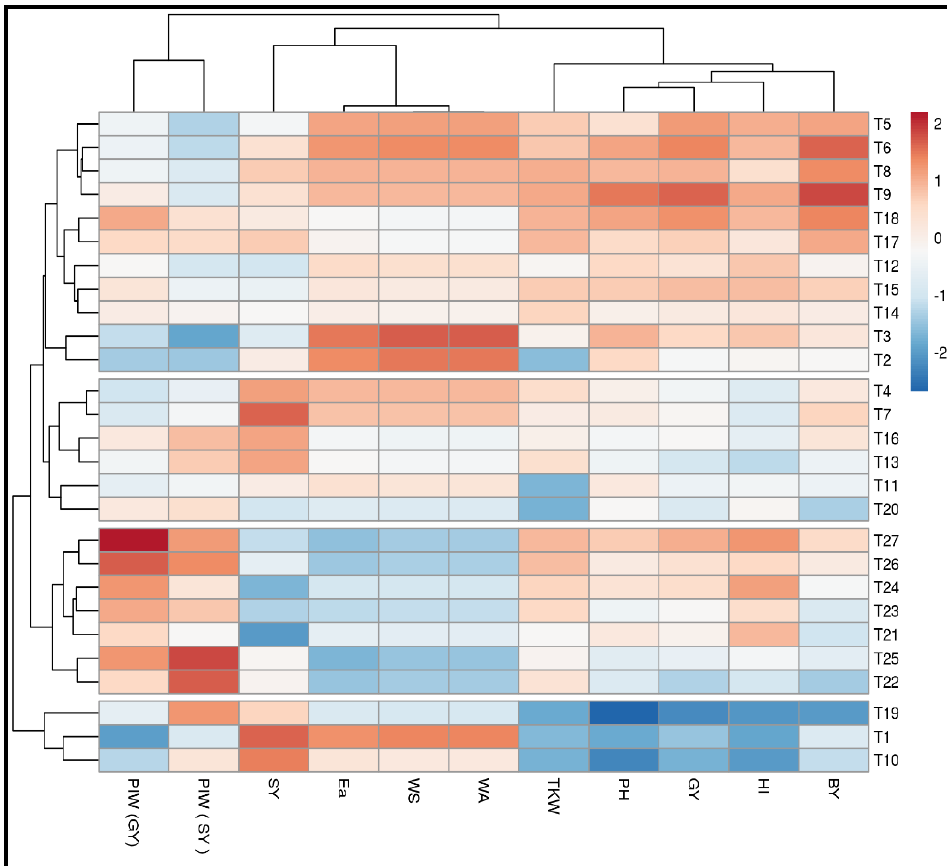
Figure 10. Hierarchical clustering heat map visualization of compound T27 treatments, for six agronomical and five water relation traits, showing the interaction among irrigation supplements, organic amendment, and nano-Zn foliar spraying on yield. The red color represents high values and blue color represents low values. High to low values are scaled according to the key above. Abbreviations: Biological yield (BY), grain yield (GY), straw yield (SY), 1000-kernels weight (TKW), plant height (PH), harvest index% (HI), Total water applied (W.A), stored water (W.S), water application efficiency (Ea), Irrigation water productivity for grain and straw (PIWGY) (PIW SY). T 1 to T 27 refer to Table